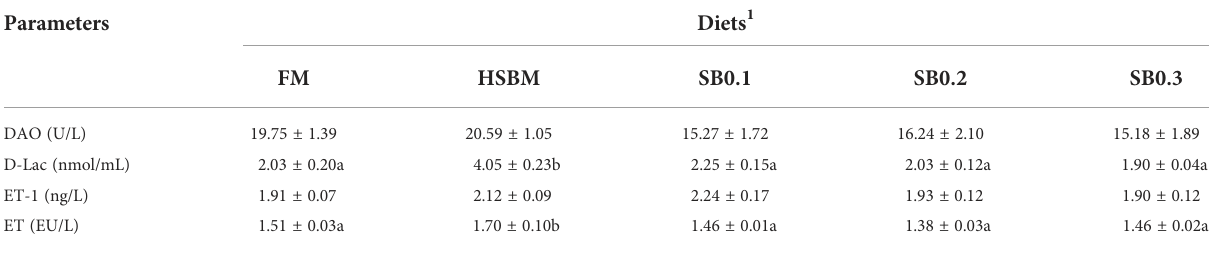
TABLE 6 Effects of sodium butyrate (SB) addition in high soybean meal (SBM) diets on intestinal permeability of groupers in a 56-d feeding period.